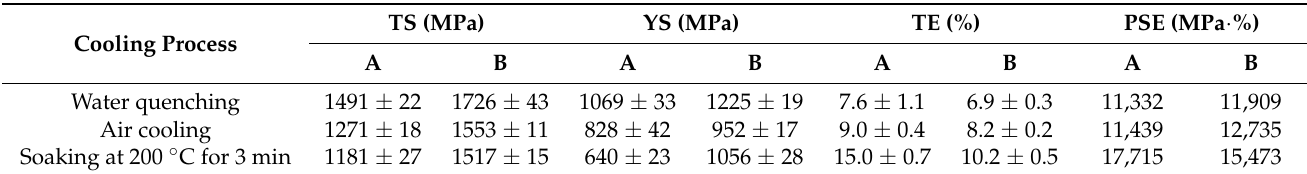
Table 5. Mechanical properties of steels heated to 800 ◦ C for 3 min then under different cooling processes. Cooling Process Water quenching Air cooling Soaking at 200 ◦ C for 3 min